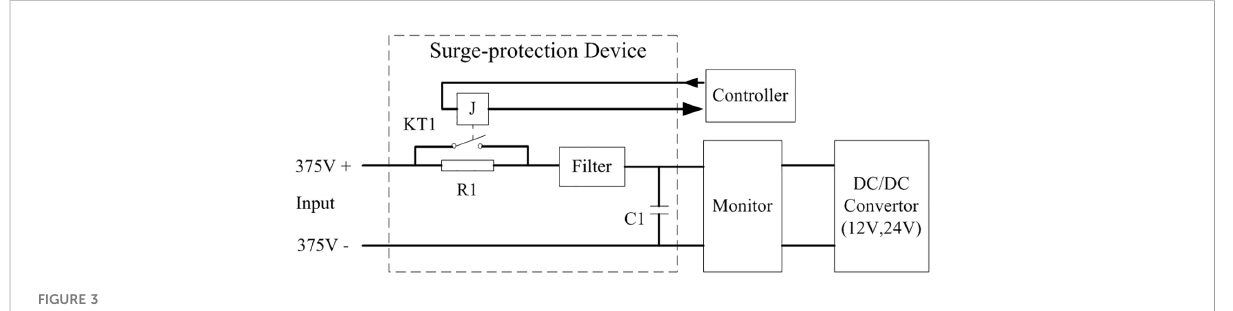
FIGURE 3 Schematic of surge-protection device.